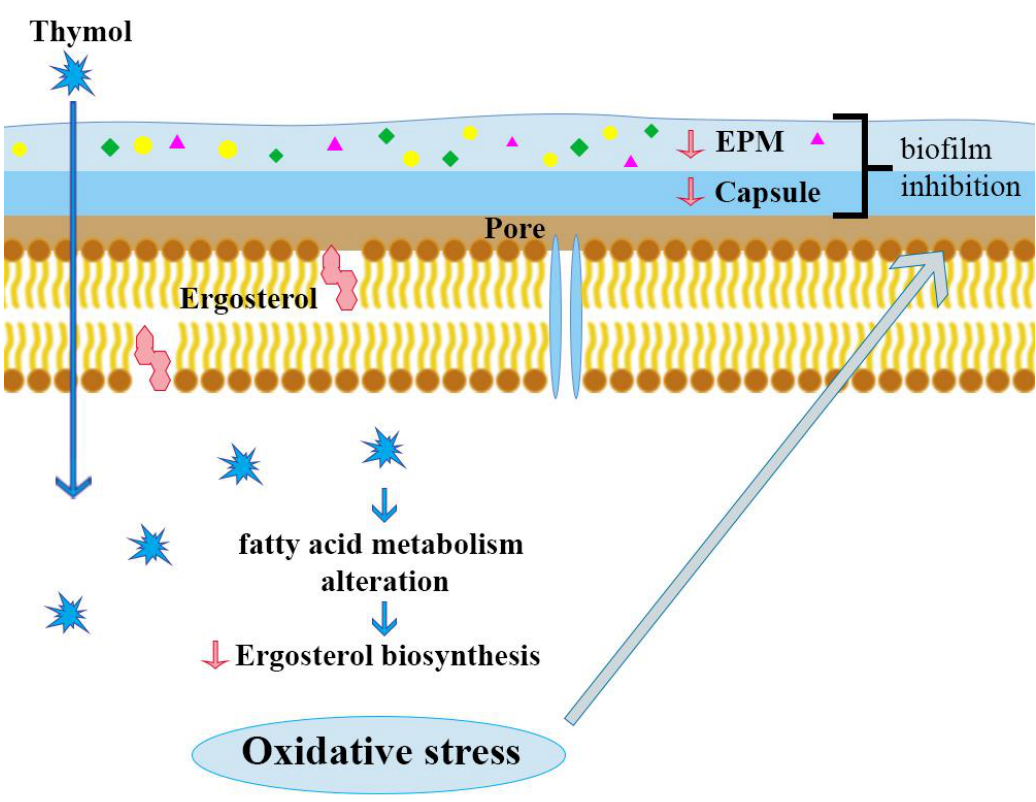
Figure 5. Possible mechanism of antifungal action of